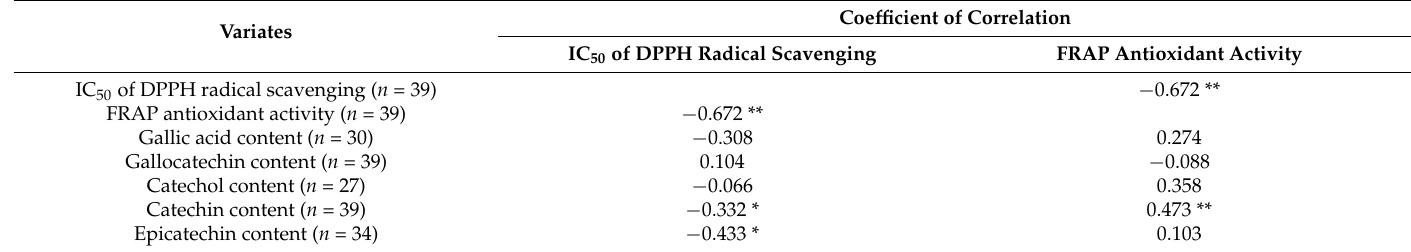
Table 6. Pearson 1 s correlation between phenolic contents and antioxidant